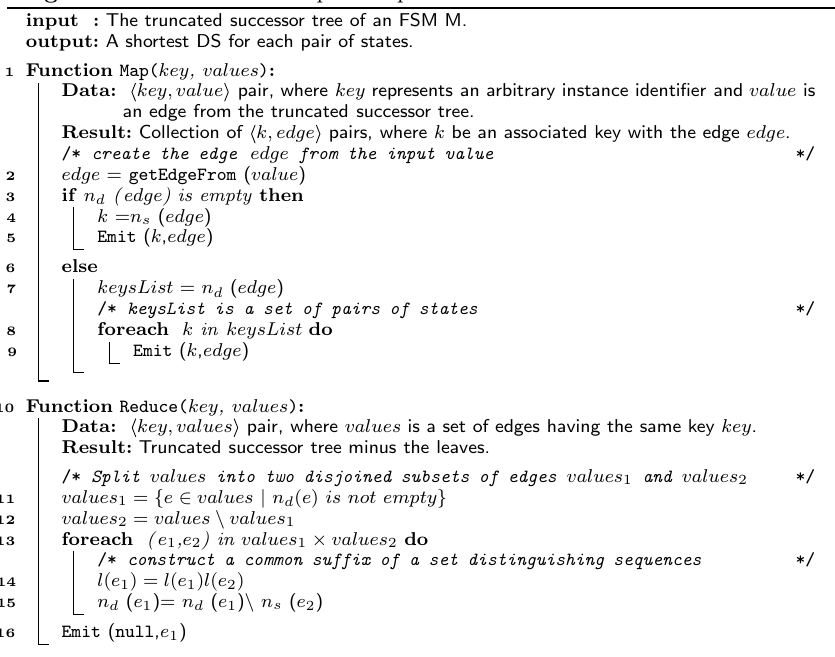
Algorithm 3: Derivation step in